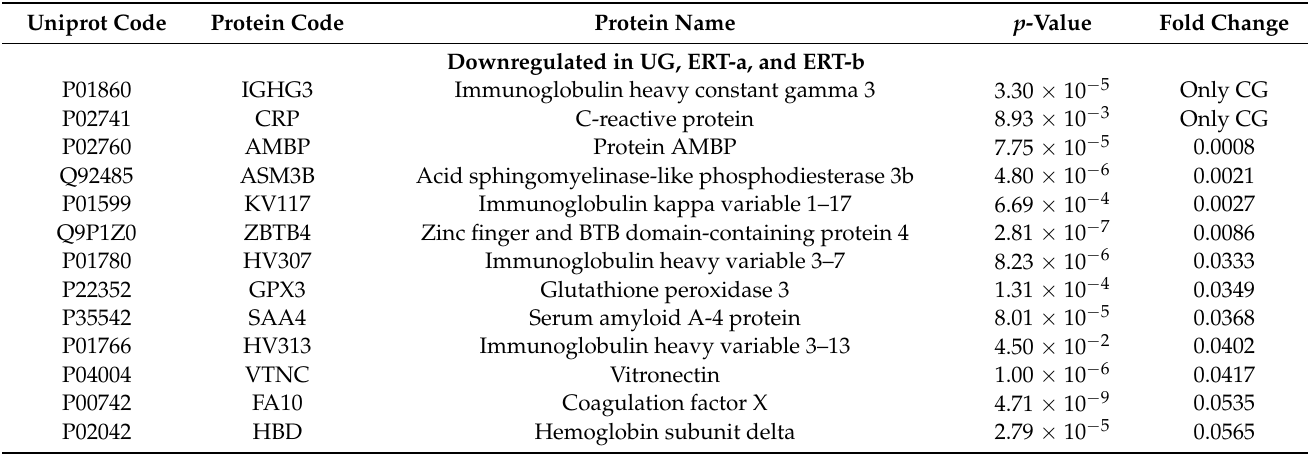
Figure 7. Volcano plot showing the results of the SWATH analysis of plasma protein expression. Data are represented as the results obtained for the control group relative to all other groups (UG, ERT-a, and ERT-b). Graph shows the negative base 10 log of the p -value plotted against the base 2 log of the fold change for each protein included in the SWATH analysis. Changes were considered significant at p < 0.05 and fold change >1.5 compared with control group. Table 2. Changes in plasma protein expression detected in all patient groups (UG, ERT-a, and ERT-b) relative to the control group. Protein expression is considered altered in cases in which p < 0.05 and the fold change >1.5 (upregulated proteins) or <0.6 (downregulated